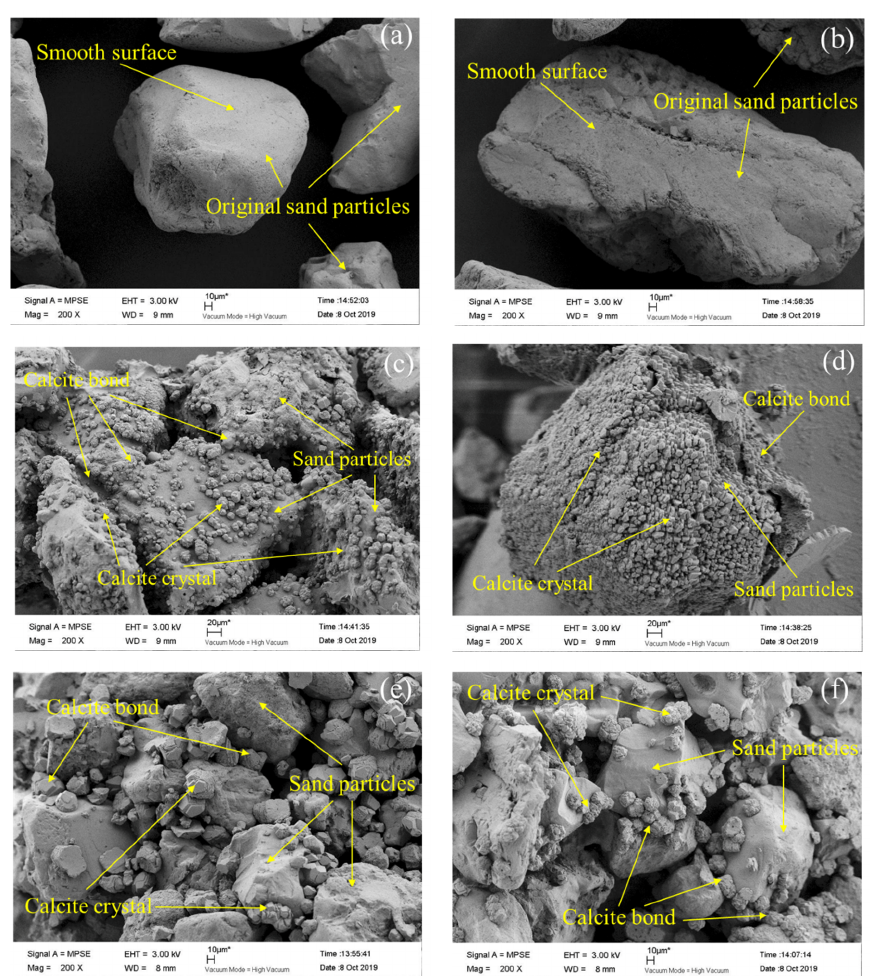
Figure 11. SEM micrographs of untreated and bio-treated column specimen magnified 200 × : ( a ) and ( b ) original sand particles specimen; ( c ) and ( d ) bio-treated specimen with lower concentration (0.5 M Urea + CaCl 2 ); ( e ) and ( f ) bio-treated specimen with higher concentration (1.5 M Urea+CaCl 2 ).